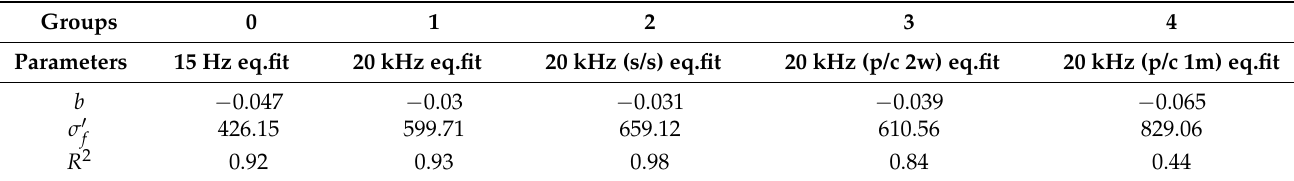
Table 2. Material parameters of the SN curves for the least squares regression lines shown in Figure 5.